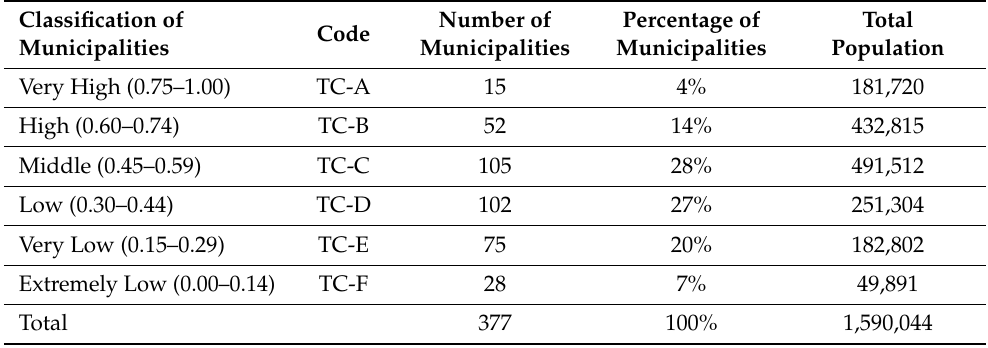
Table 3. Classification of Sardinian municipalities based on Territorial Capital (TC) scores: categories TC-E and TC-F are associated to a peripheral condition (elaborated by